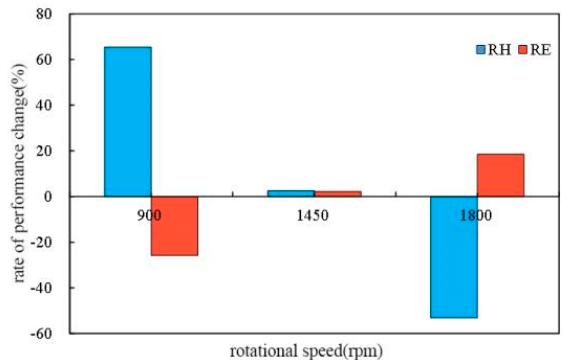
Figure 22. Influence of different rotational speeds on pump performance.